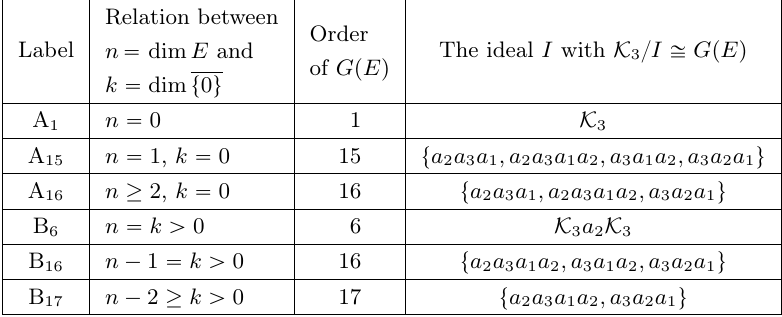
Table 1. The monoids G p E q for finite-dimensional E